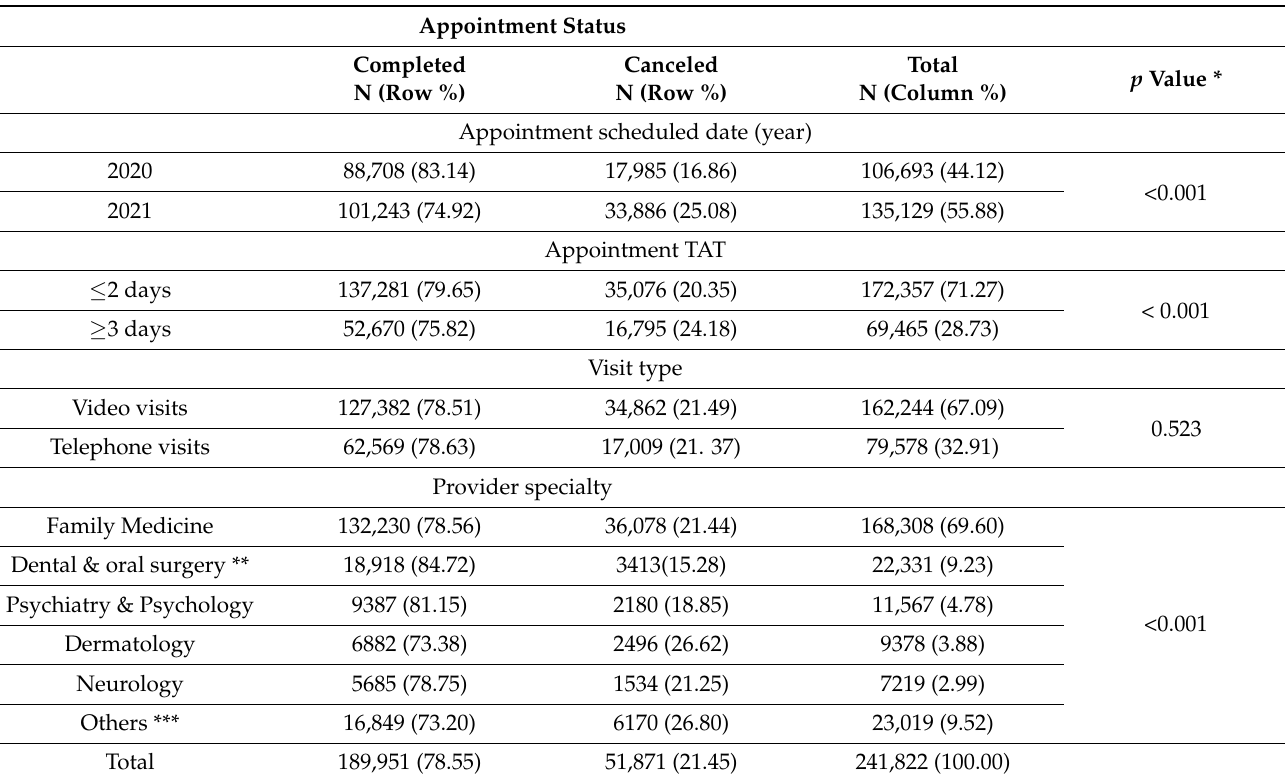
Table 2. Visit characteristics of patients who scheduled a telehealth visit at DHA, by